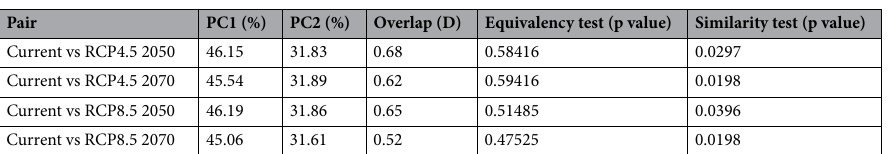
Table 8. Niche comparisons and first two principal components between current and future projected distribution of the studied species ( Rheum webbianum ).